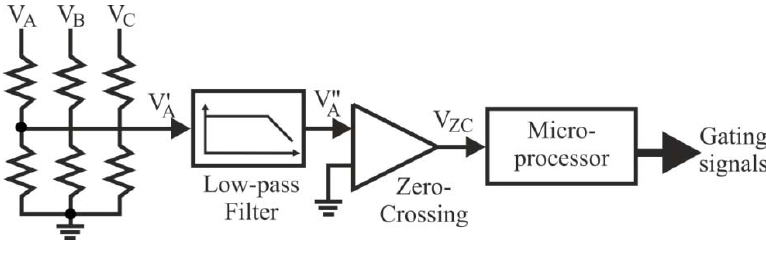
Figure 24. Block diagram of the FPGA-based drive for DVD spindle applications